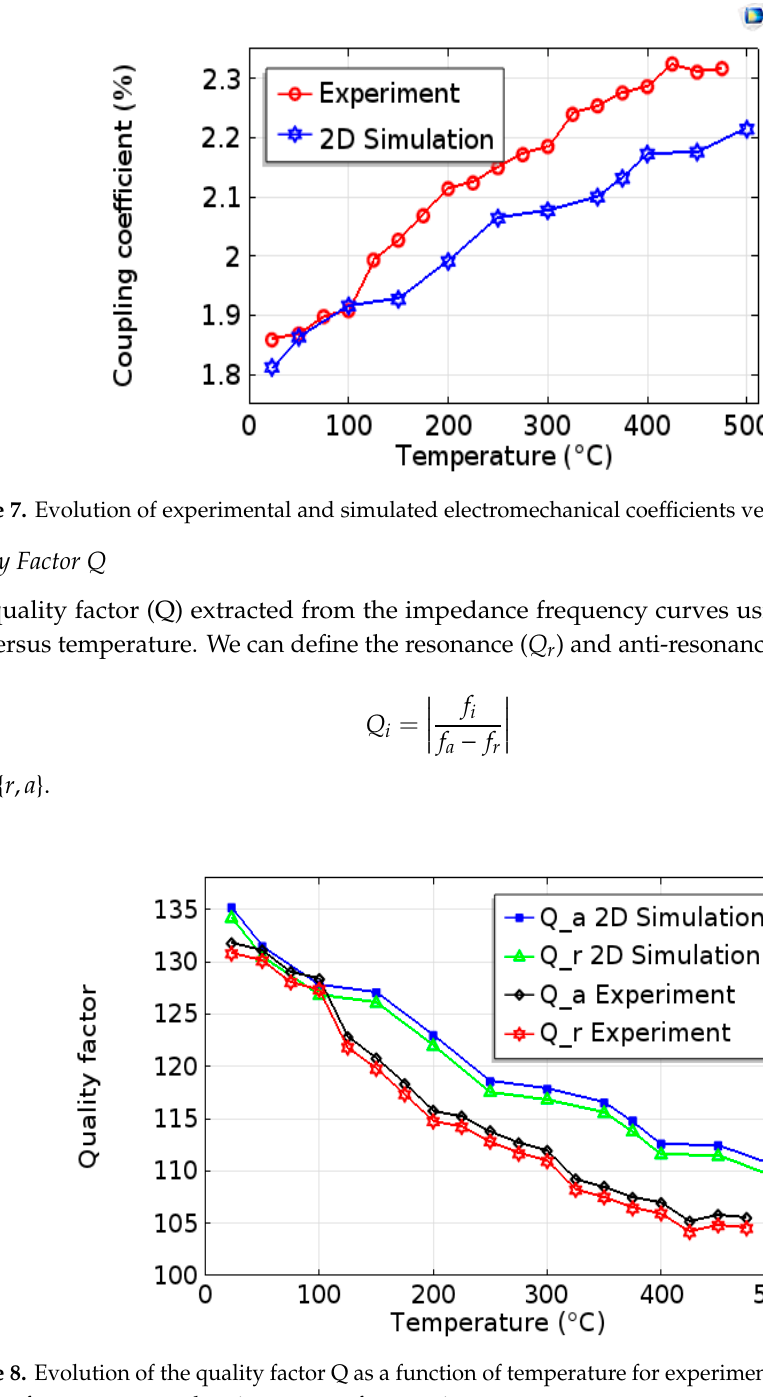
Figure 8. Evolution of the quality factor Q as a function of temperature for experimental and simulated devices, for resonance and anti-resonance frequencies.